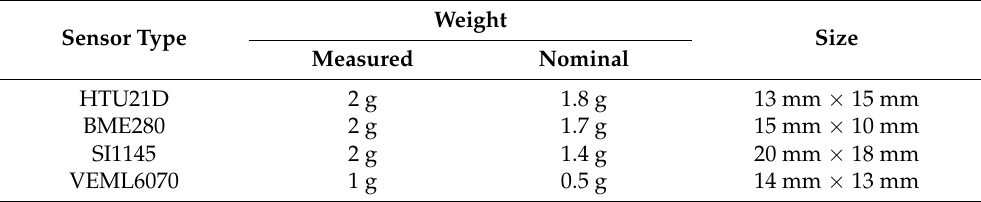
Table 14. Weight and size of sensors selected for the use in the flying weather